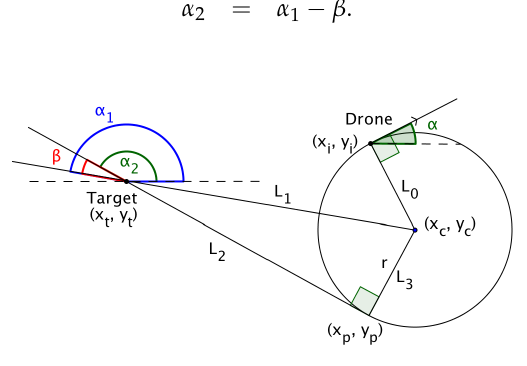
Figure 10. Target lies to the left of the UAV’s straight line